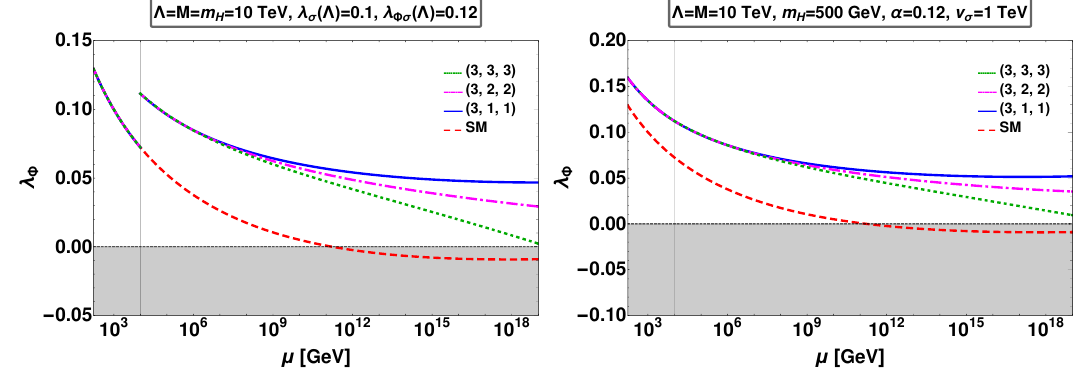
Figure 11 . Comparing the evolution of the quartic Higgs self-coupling λ in the Standard Model (red dashed) with the majoron inverse seesaw mechanism: the minimal (3,1,1) is denoted in solid (blue), (3,2,2) is dot-dashed (magenta) and (3,3,3) is dotted (green). See text for